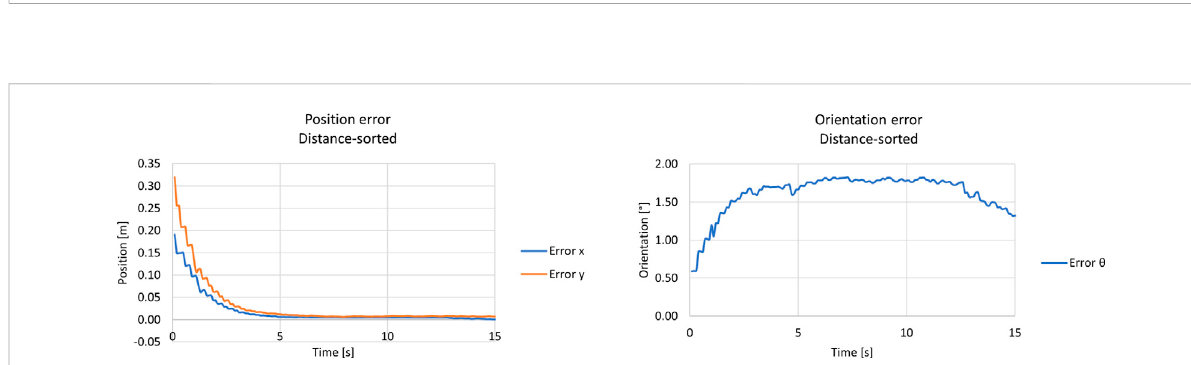
FIGURE 16 Results from thekidnappedrobottestwith theunsort approachand without Mahalanobis fi lter.The upperleftgraph displaystheposition error, the upper right, the orientation error, and the bottom graph shows the main diagonal of the EKF ’ s covariance estimate.